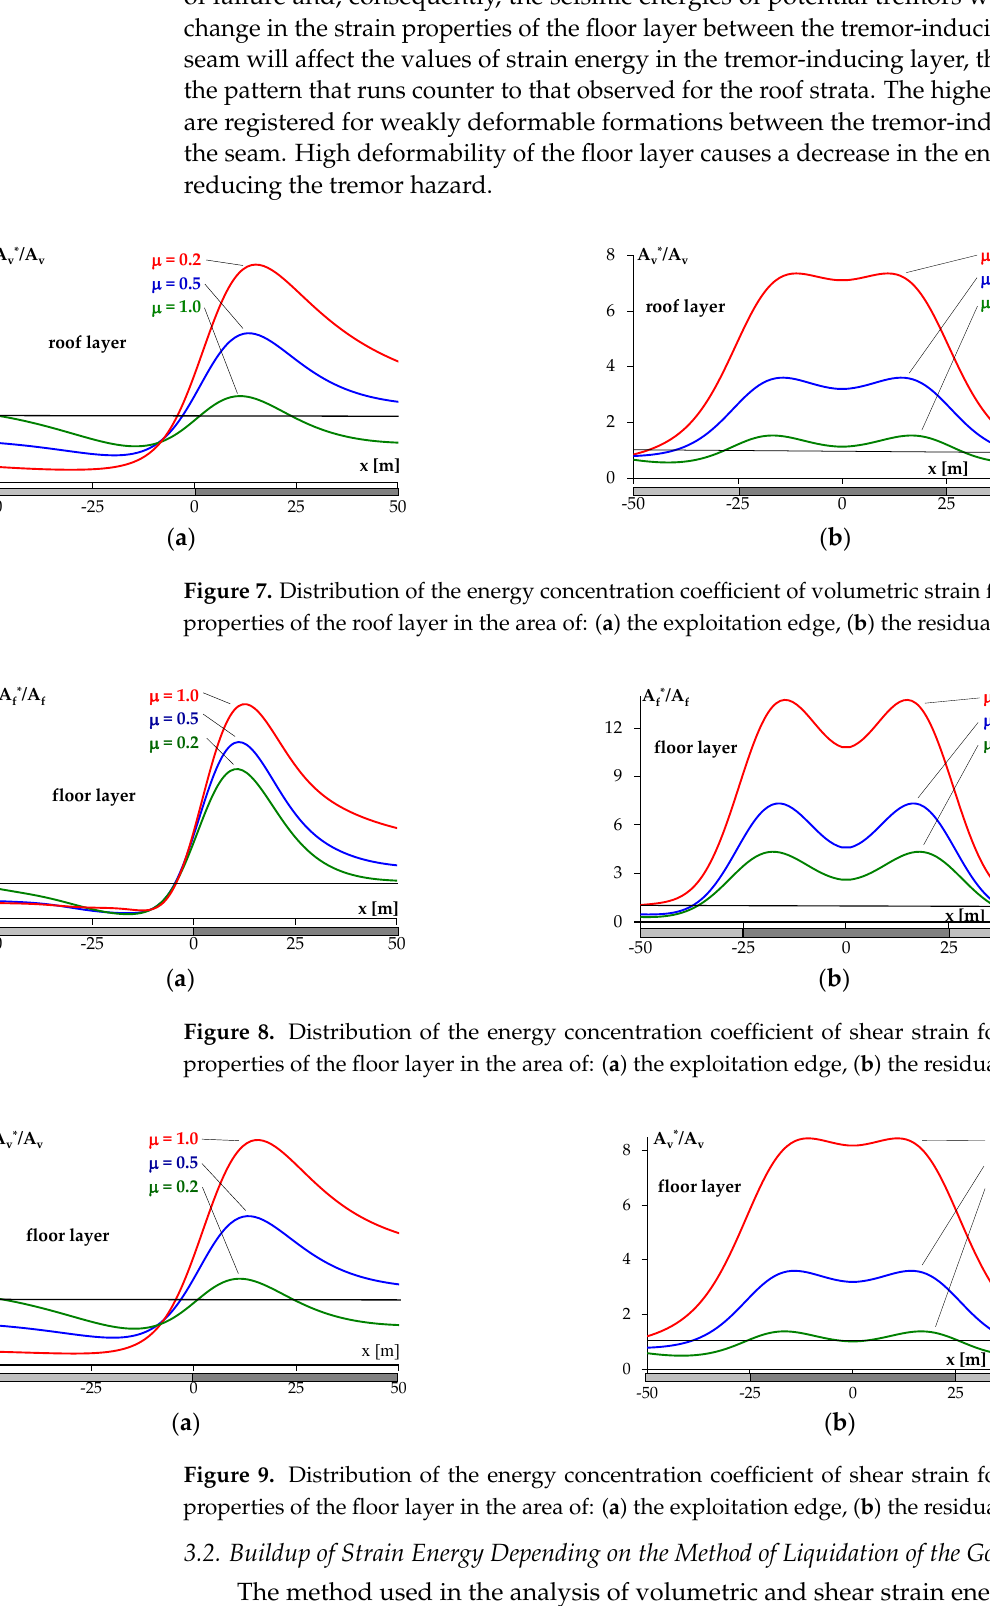
(42) where : E str(sp) — Young modulus of the roof (floor) (Pa), E wst — Young modulus of the tremor-inducing layer (Pa), ν str(sp) — Poisson ratio of the roof (floor) strata(−) and ν wst — Pois- son ratio of the tremor- inducing layer (−). Input data used in the calculation procedure are: